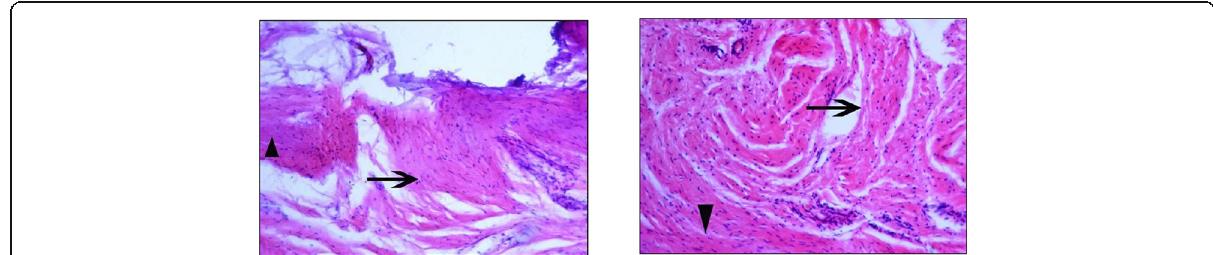
Fig. 2 Predominance of the oblique fibres in the right and left borders of the ring of the direct umbilical hernia (the arrow points to the oblique fibres while the arrowhead points to the transverse fibres)